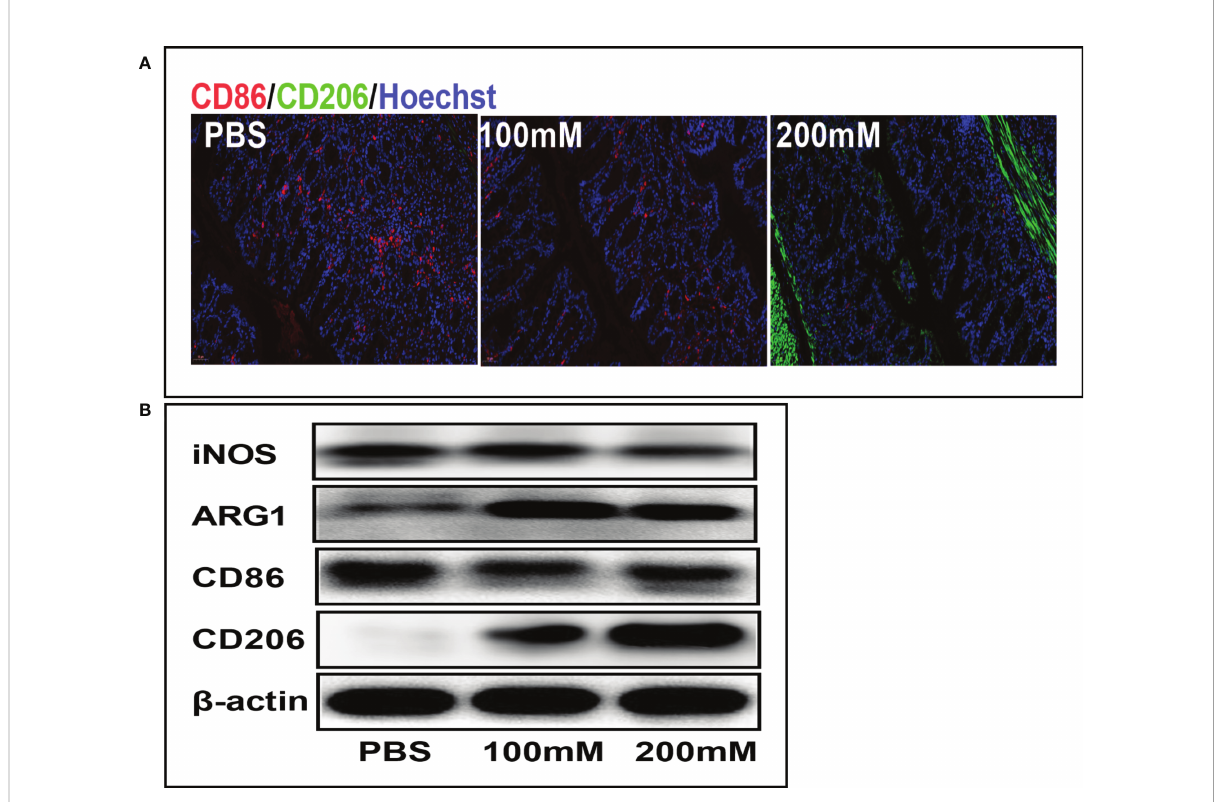
FIGURE 5 Lactic acid promoted M2 polarization of macrophages in colon tissues. (A) Representative fl uorescent images of the macrophage phenotypes in colon tissues in different groups. Scale bar, 100 m m. (B) Western blotting analysis showing expression level of macrophage phenotypic markers in colon tissues for different